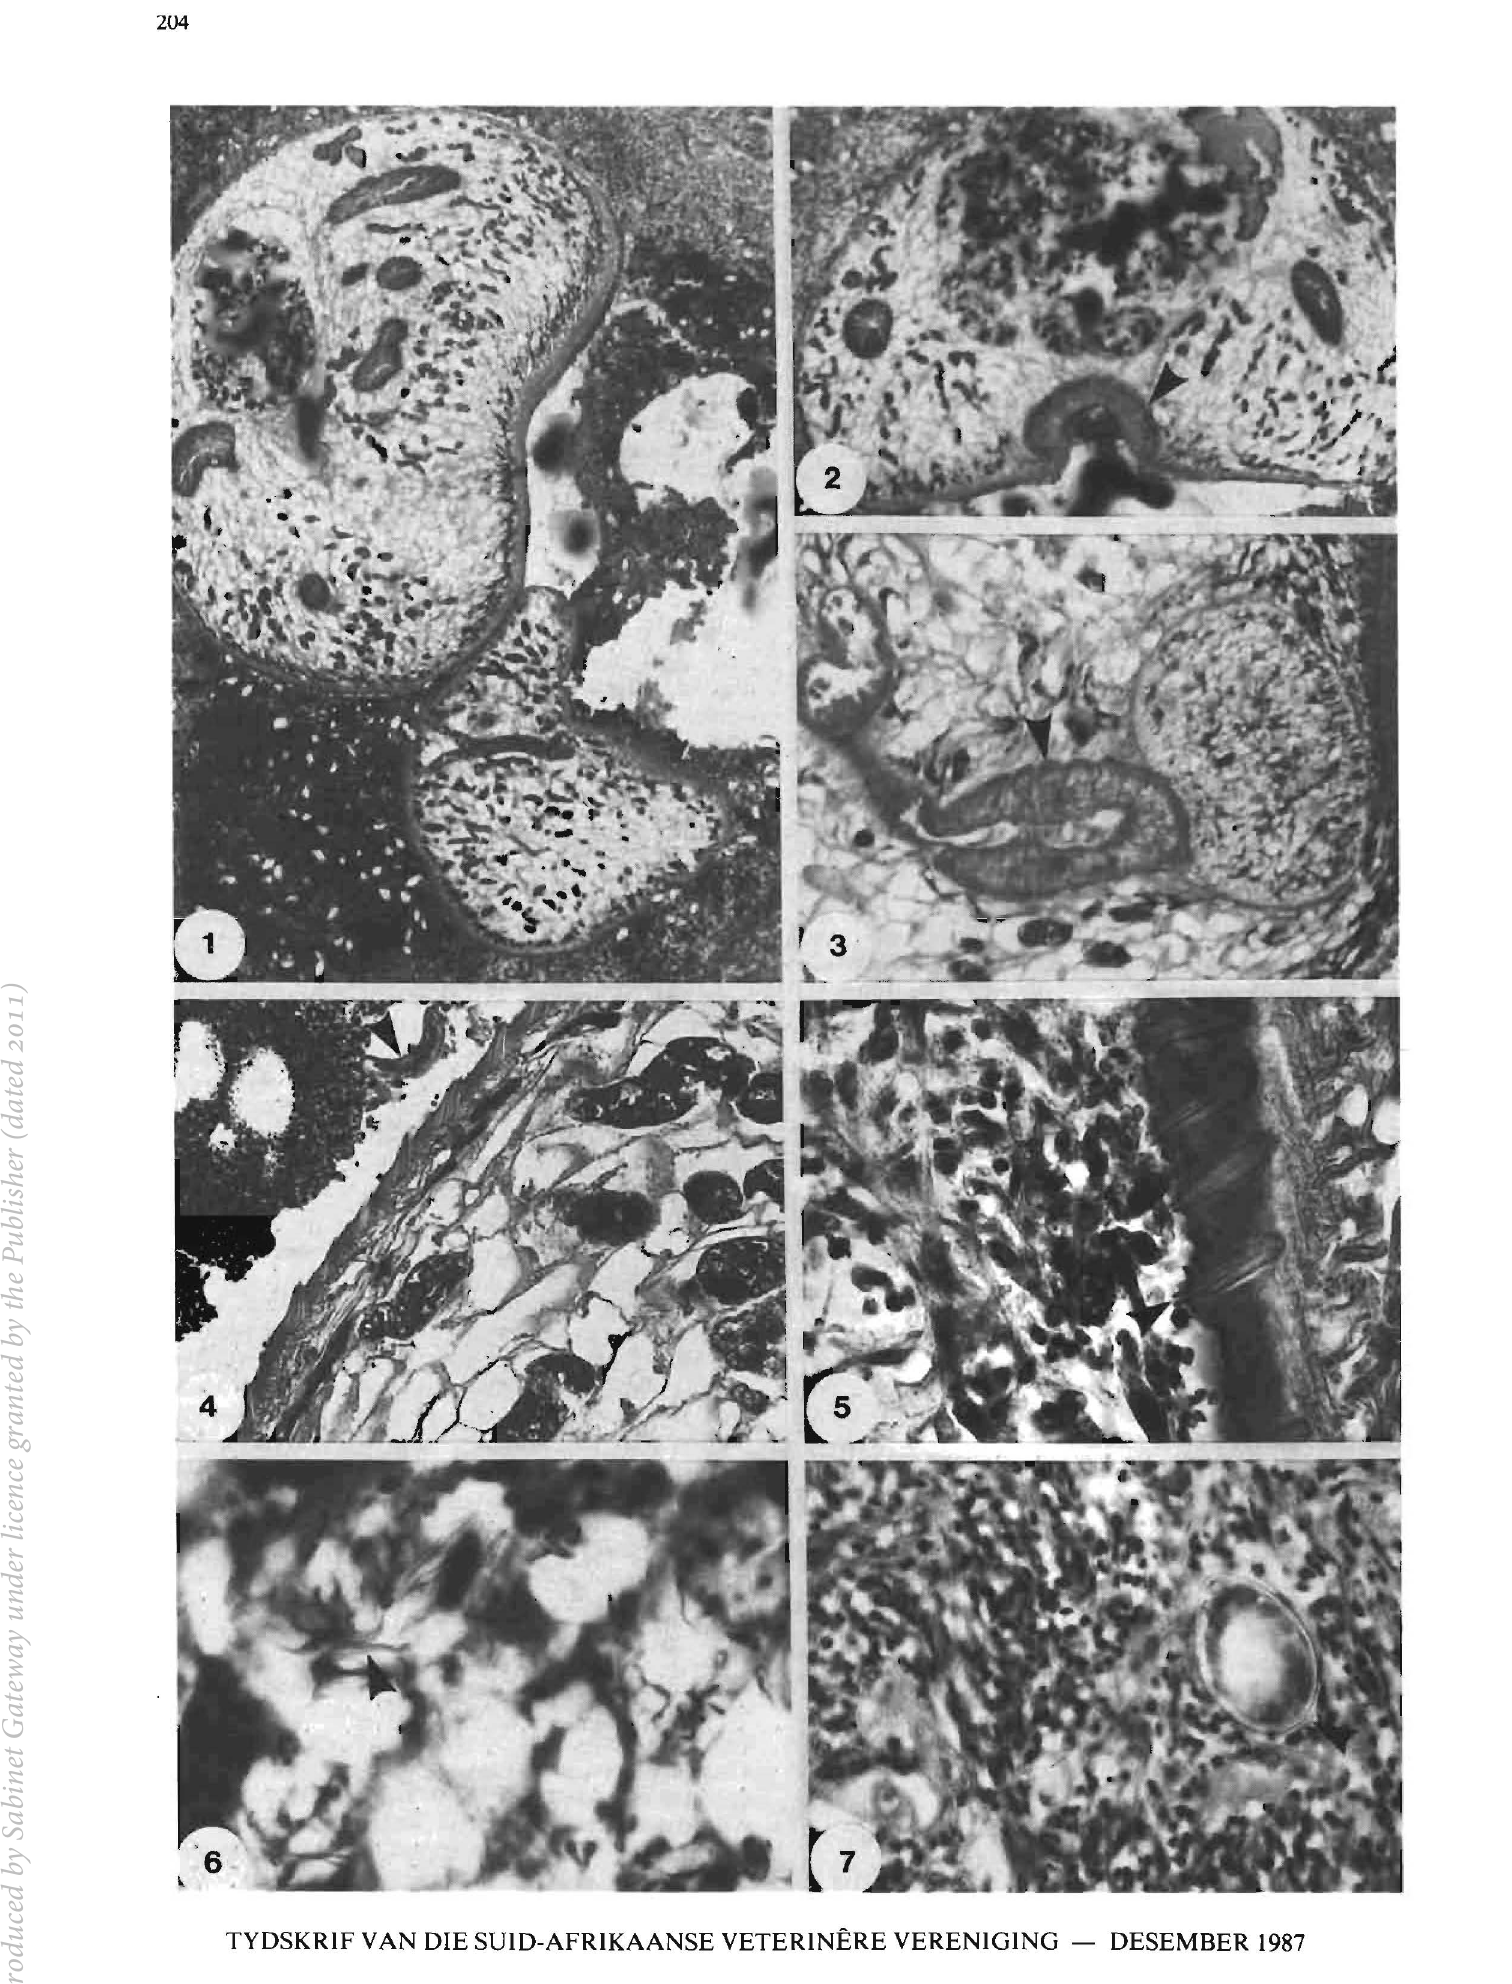
TYDSKRIF VAN DIE SUlD-AFRIKAANSE VETERINERE VERENIGING - DESEMBER